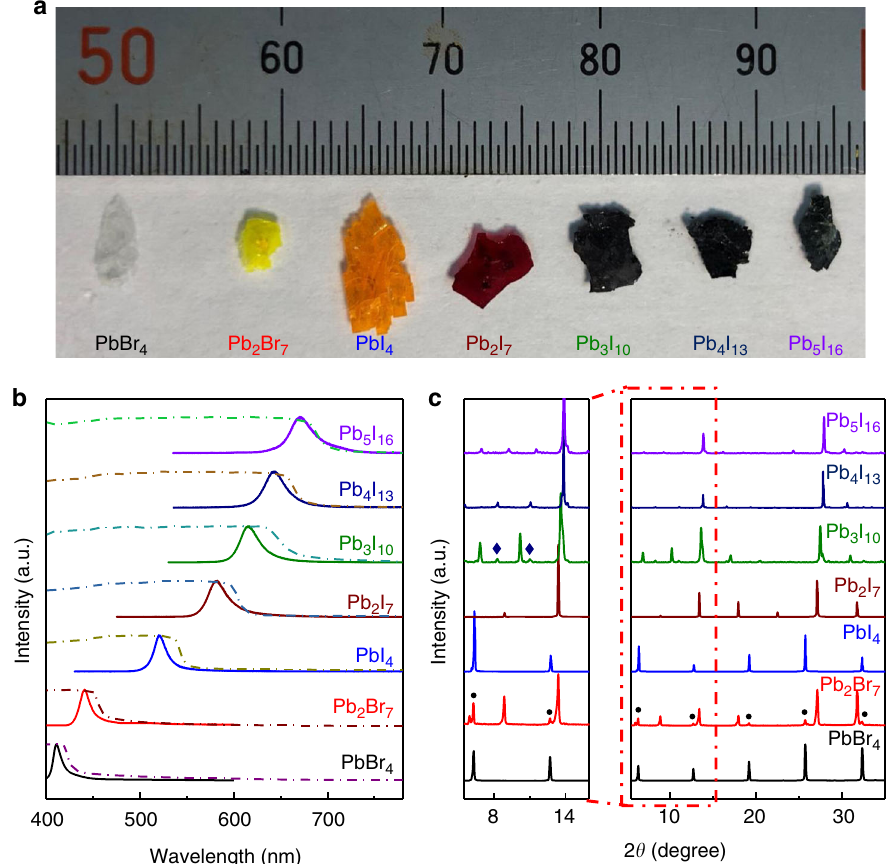
Fig. 1 Characterizations of 2D perovskite single crystals. a Photograph of the as-synthesized perovskite single-crystal plates. From left to right: (BA) 2 (MA) n − 1 Pb n Br 3 n + 1 (denoted as Pb n Br 3 n + 1 ) and (BA) 2 (MA) n − 1 Pb n I 3 n + 1 (denoted as Pb n I 3 n + 1 ). b Absorption (dash line) and photoluminescence (solid line) spectra of the perovskite plates. c Powder XRD spectra of the perovskite crystal plates. The low angle part is magni fi ed to clearly see the diffraction peaks for impurity phases. Black dot: (BA) 2 PbBr 4 phase within (BA) 2 (MA)Pb 2 Br 7 ; Navy rhombus: (BA) 2 (MA) 3 Pb 4 I 13 phase within (BA) 2 (MA) 2 Pb 3 I